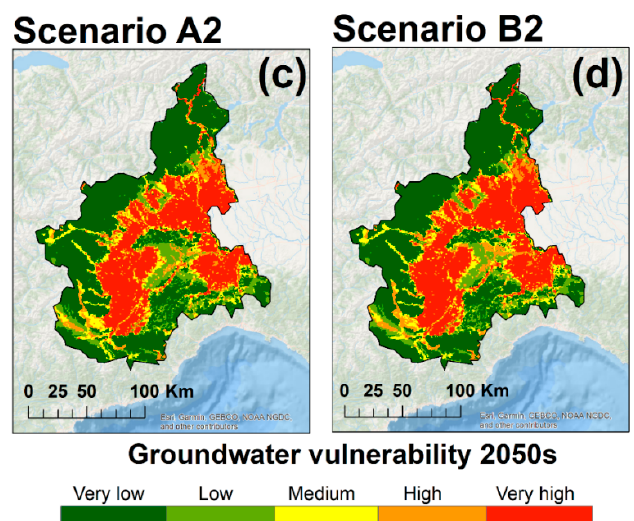
Figure 7. Groundwater vulnerability map of the Piedmont region. ( a ) Groundwater vulnerability map related to the future period (2050s), Scenario A1; ( b ) Groundwater vulnerability map related to the future period (2050s), Scenario B1; ( c ) Groundwater vulnerability map related to the future period (2050s), Scenario A2; ( d ) Groundwater vulnerability map related to the future period (2050s), Scenario B2. Background image source: Esri, Garmin, GEBCO, NOAA NGDC, and other contributors. Source: Nistor et al. (2019).